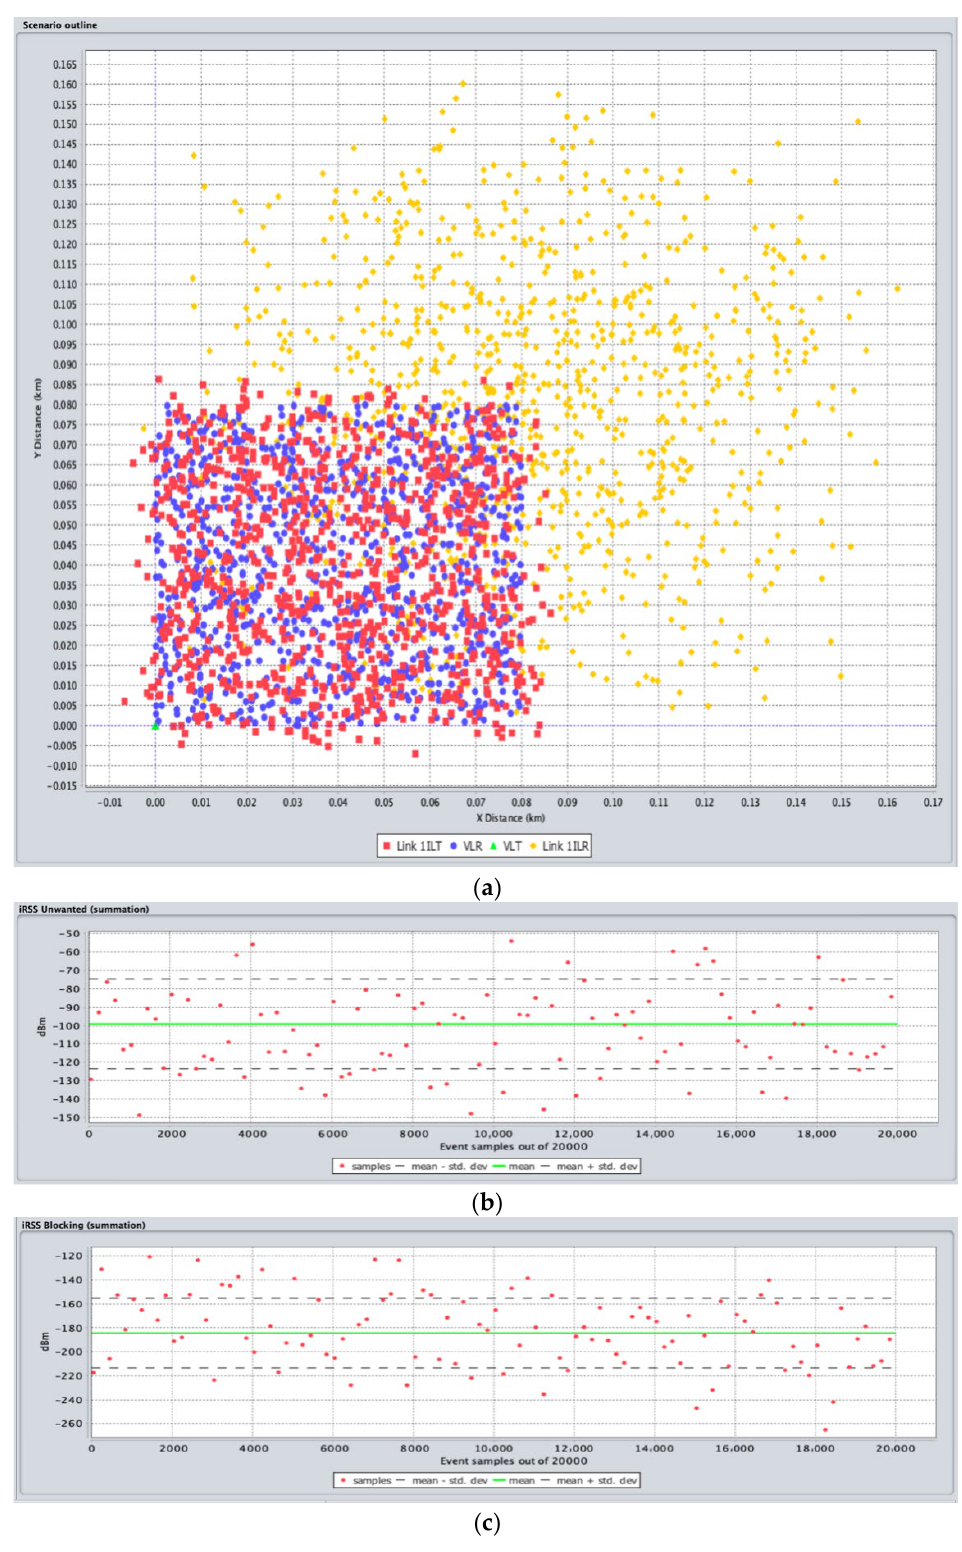
Figure 8. Example of simulation for interference modeling with SEAMCAT: ( a ) a shop floor area with victim link and interfering link positions (VLT: Victim Link Transmitter; ILT: interfering link transmitter; VLR: victim link receiver; ILR: interfering link receiver); event samples of the sum of interfering transmissions of ( b ) unwanted emissions and ( c ) receiver blocking.